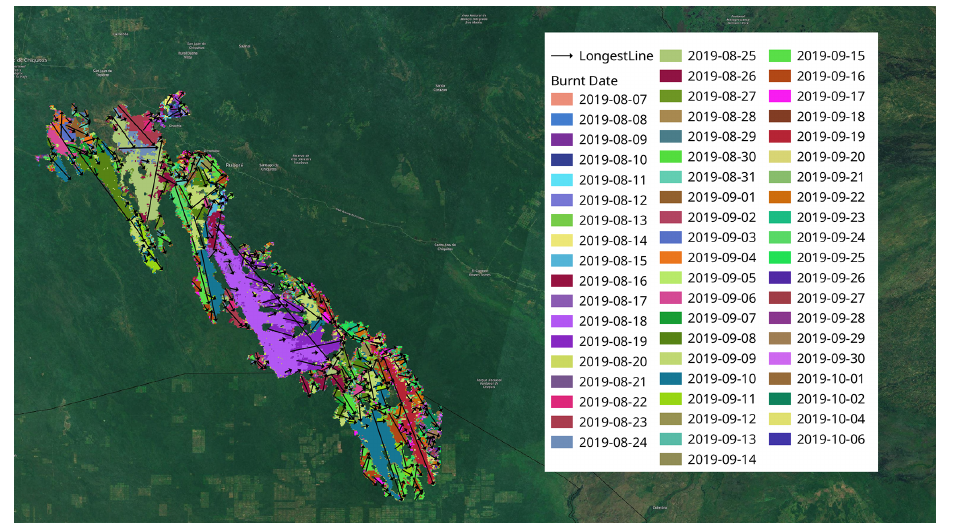
Figure 9. Daily burnt area for the duration of wildfire in Roboré, Bolivia, in 2019. The maximum speed line between time steps is shown with a black arrow. The missing days do not have any daily burnt area in GlobFire. Background image © MapTiler (https://maptiler.com/copyright, last access: 18 March 2021). Please note that the date format in this figure is yyyy-mm-dd.